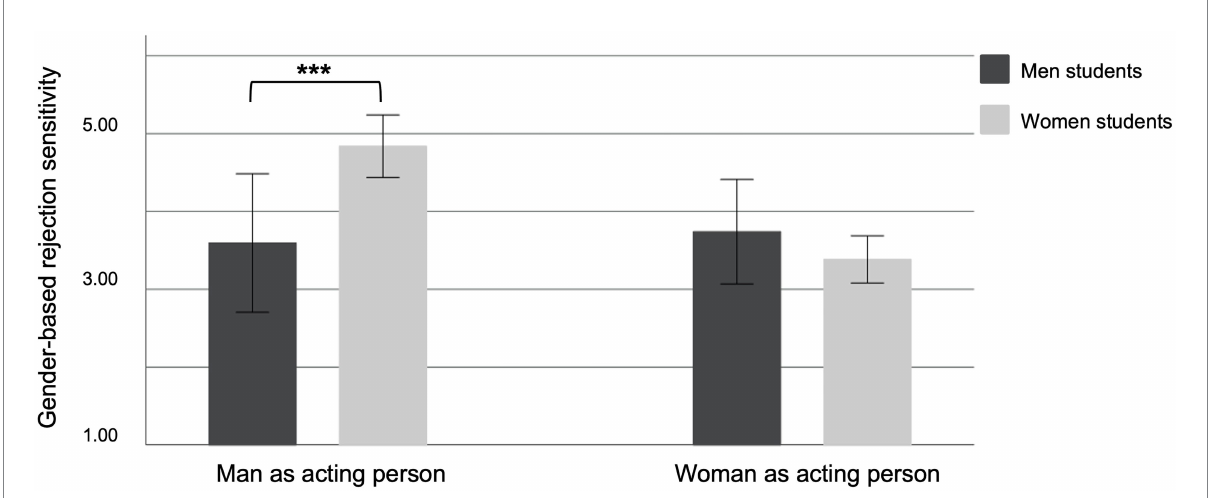
FIGURE 1 Gender-based rejection sensitivity depending on the acting person’s gender and of participants’ gender. Depicted are mean total scores with 95% confidence intervals of the gender-based rejection sensitivity scale. Asterisks highlight significant between-group differences. *** p <